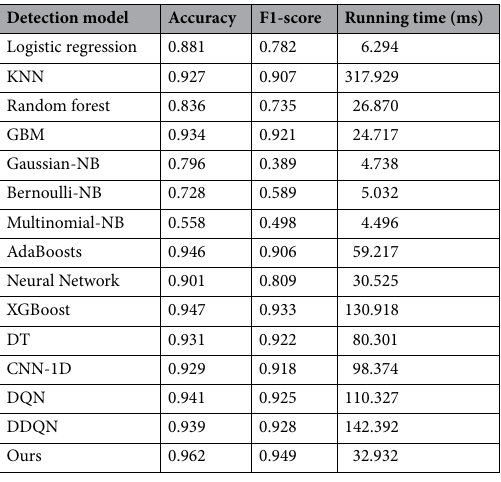
Table 6. Comparison of prediction performance and running time of multiple